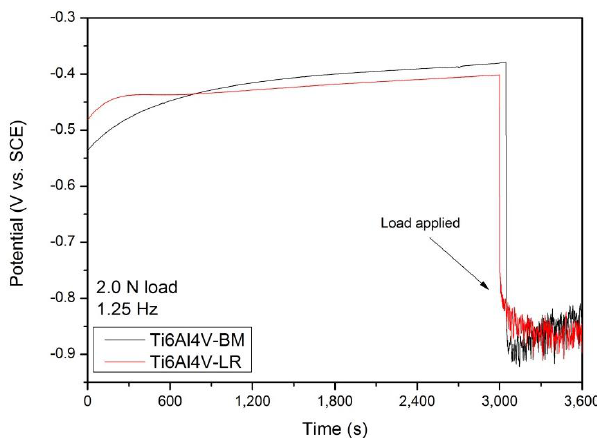
Figure 8. Open circuit potential before and during the mechanical loading.